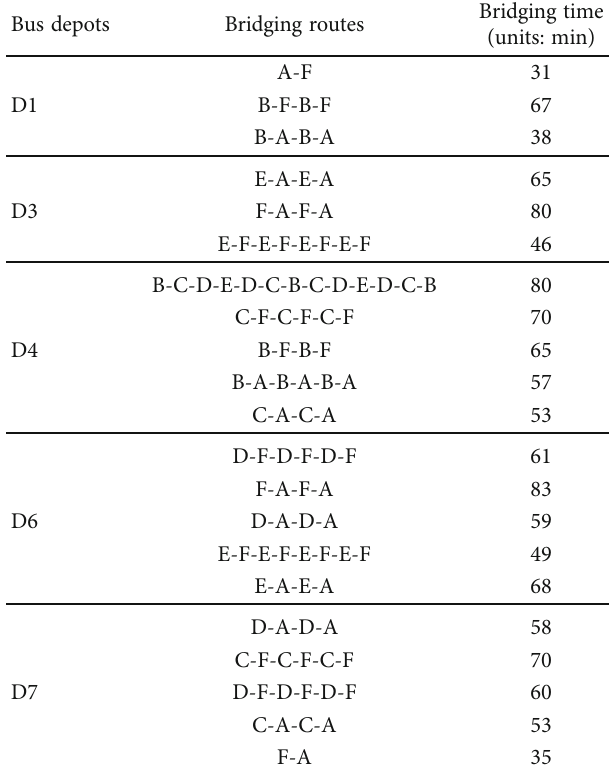
Table 9: Optimized bus bridging routes and bus bridging time. Bus depots